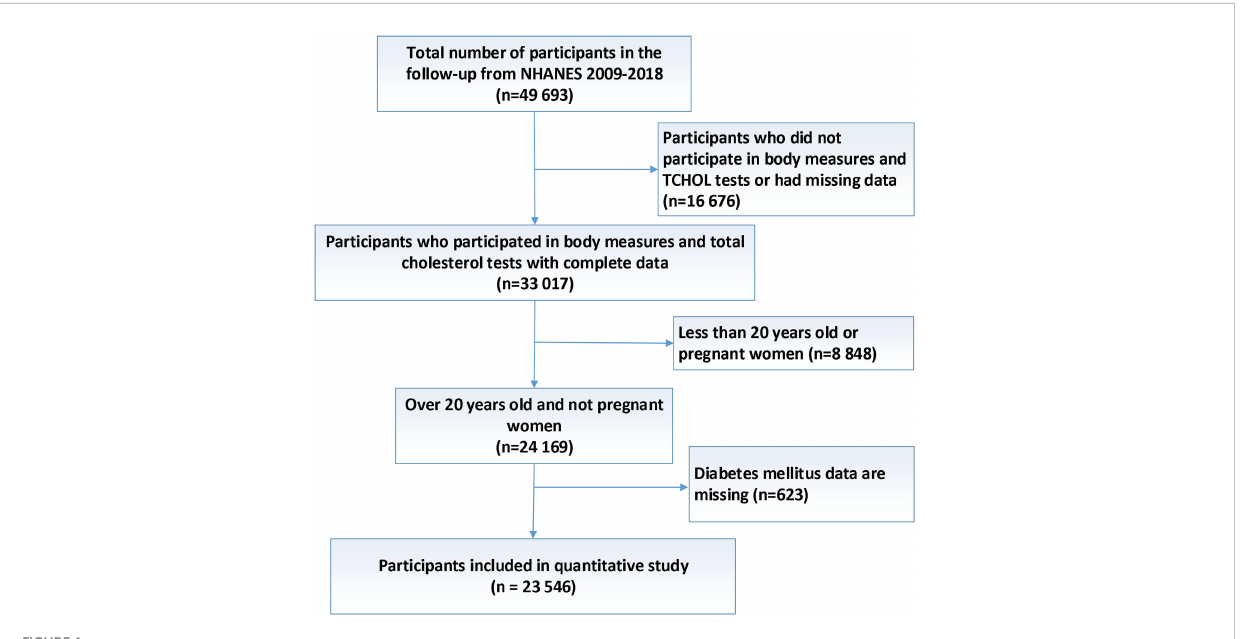
FIGURE 1 Flow diagram of participants inclusion for